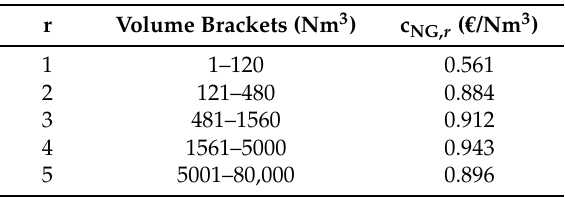
Figure 8. Primary energy saving of the ASs with 0% of solar thermal energy surplus used and flat- plate collectors in the four alternative configurations: ( a ) Scenario A; ( b ) Scenario B; ( c ) Scenario C; and ( d ) Scenario D.